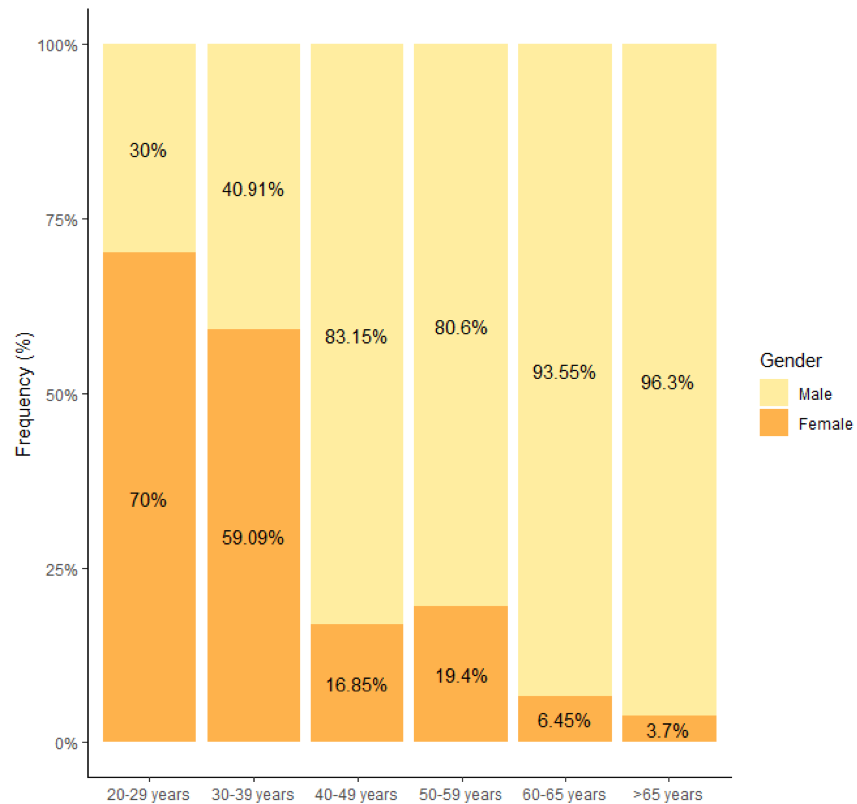
Figure 1. Age distribution by gender ( n =